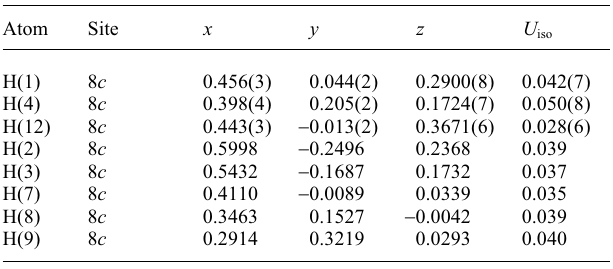
Table 3. Atomic coordinates and displacement parameters (in Å 2 )